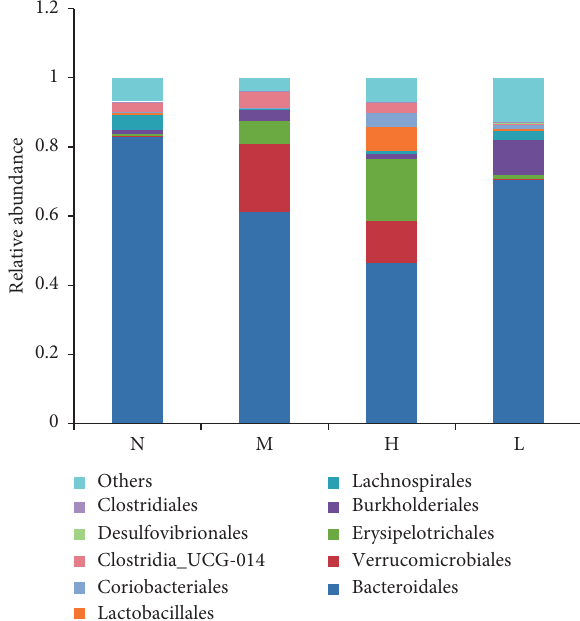
Figure 13: Relative abundance at the order level.